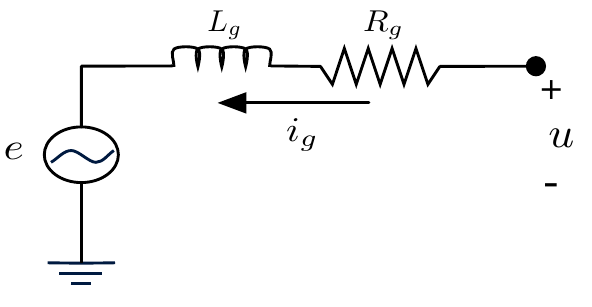
Figure 2. Simplified AC circuit